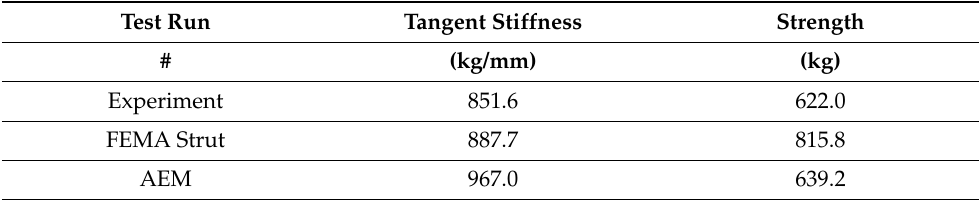
Table 3. Reported results of Pushover Curves for scaled Infilled Wall Structure.